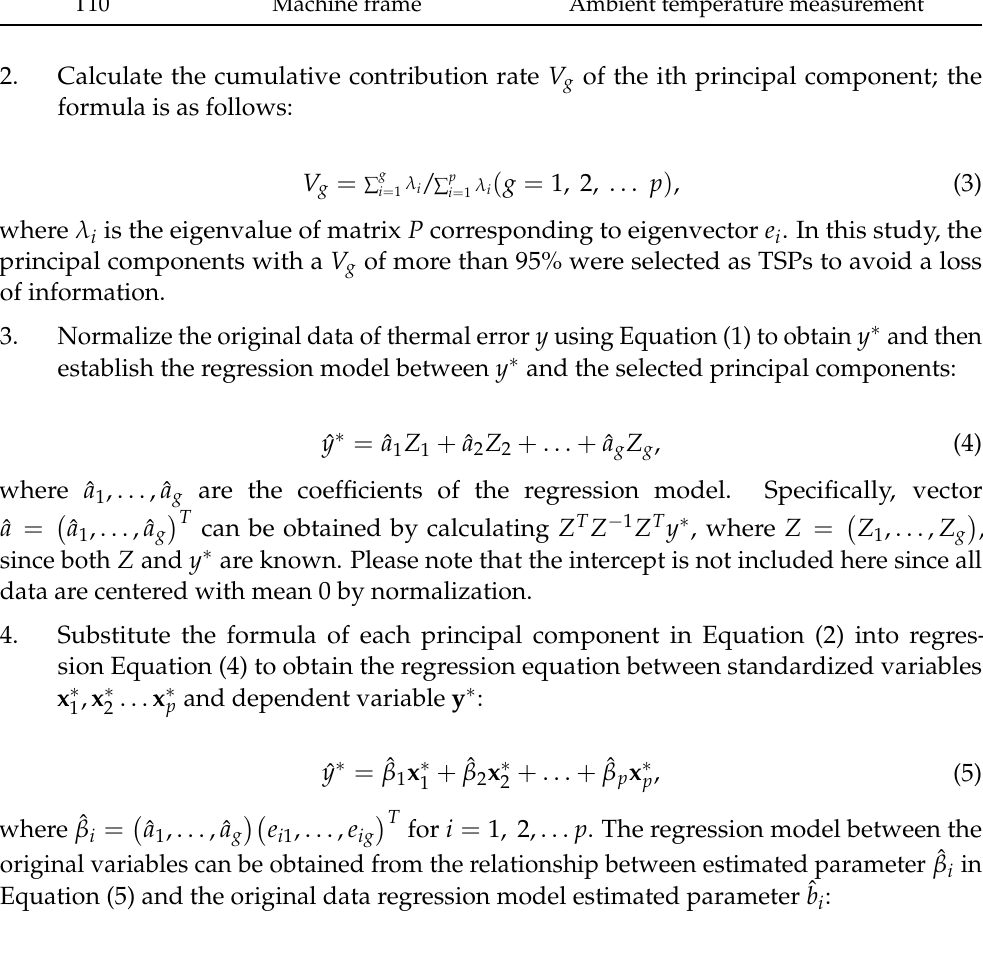
Figure 1. Experimental object. Table 1. Installation sites and measurement functions of temperature sensors. Sensors Installation Site Function T1~T5 Front bearing of Spindle Bearing temperature measurement T7,T8 Spindle motor Spindle motor temperature measurement T6,T9 Spindle box Spindle box temperature measurement T10 Machine frame Ambient temperature measurement